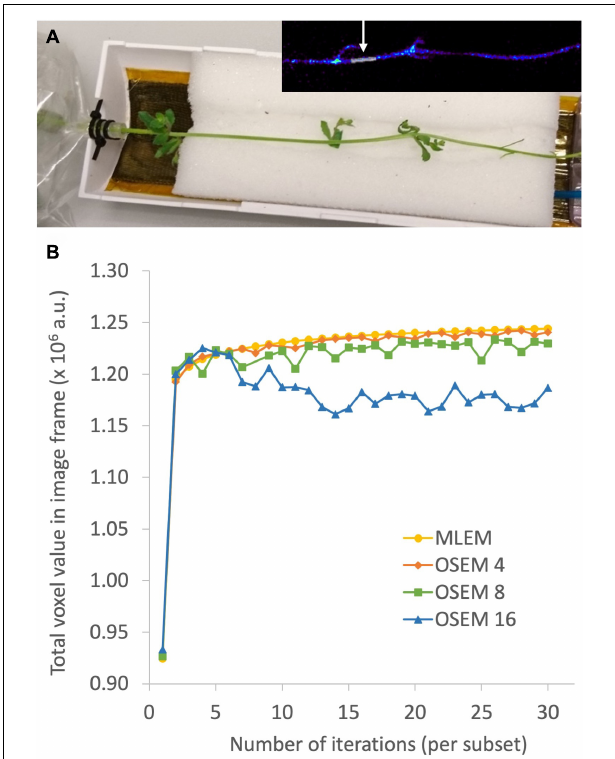
FIGURE 5 | Photograph of a plant-PET setup for a study on visualizing phloem transport in Arabidopsis (A) . The rosette of the plant was hereby labeled with one pulse of 11 CO 2 , while the inflorescence was positioned inside the field of view. The OSEM reconstructed time frame using 4 subsets and 30 iterations per subset is inserted in the right top corner. The region of interest, indicated by the arrow, was drawn on the reconstructed time frame and used to calculate the signal-to-noise ratio (SNR - Table 5 ). The effect of reconstruction algorithms MLEM and OSEM as well as the effect of a varying number of OSEM subsets X (indicated by OSEM X) on plant-PET data was investigated based on the convergence of the sum of all voxel values in the reconstructed time frame as a function of the number of iterations per subset (B) . Stable convergence of the total voxel value implies that more iterations will not result in a qualitatively better image, on the contrary, the noise present can be amplified with further